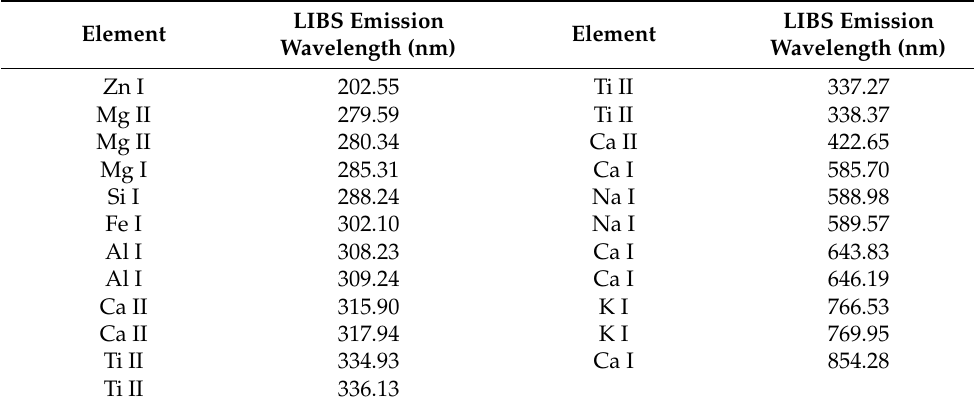
Table 1. The twenty-three emission lines identified in the LIBS spectrum of a sweet orange leaf, which were relevant for the discrimination among the accessions of sweet orange. The roman number I after the element symbol indicates an atomic line and II an ionic line. LIBS emission line wavelength corresponds to the maximum intensity of that